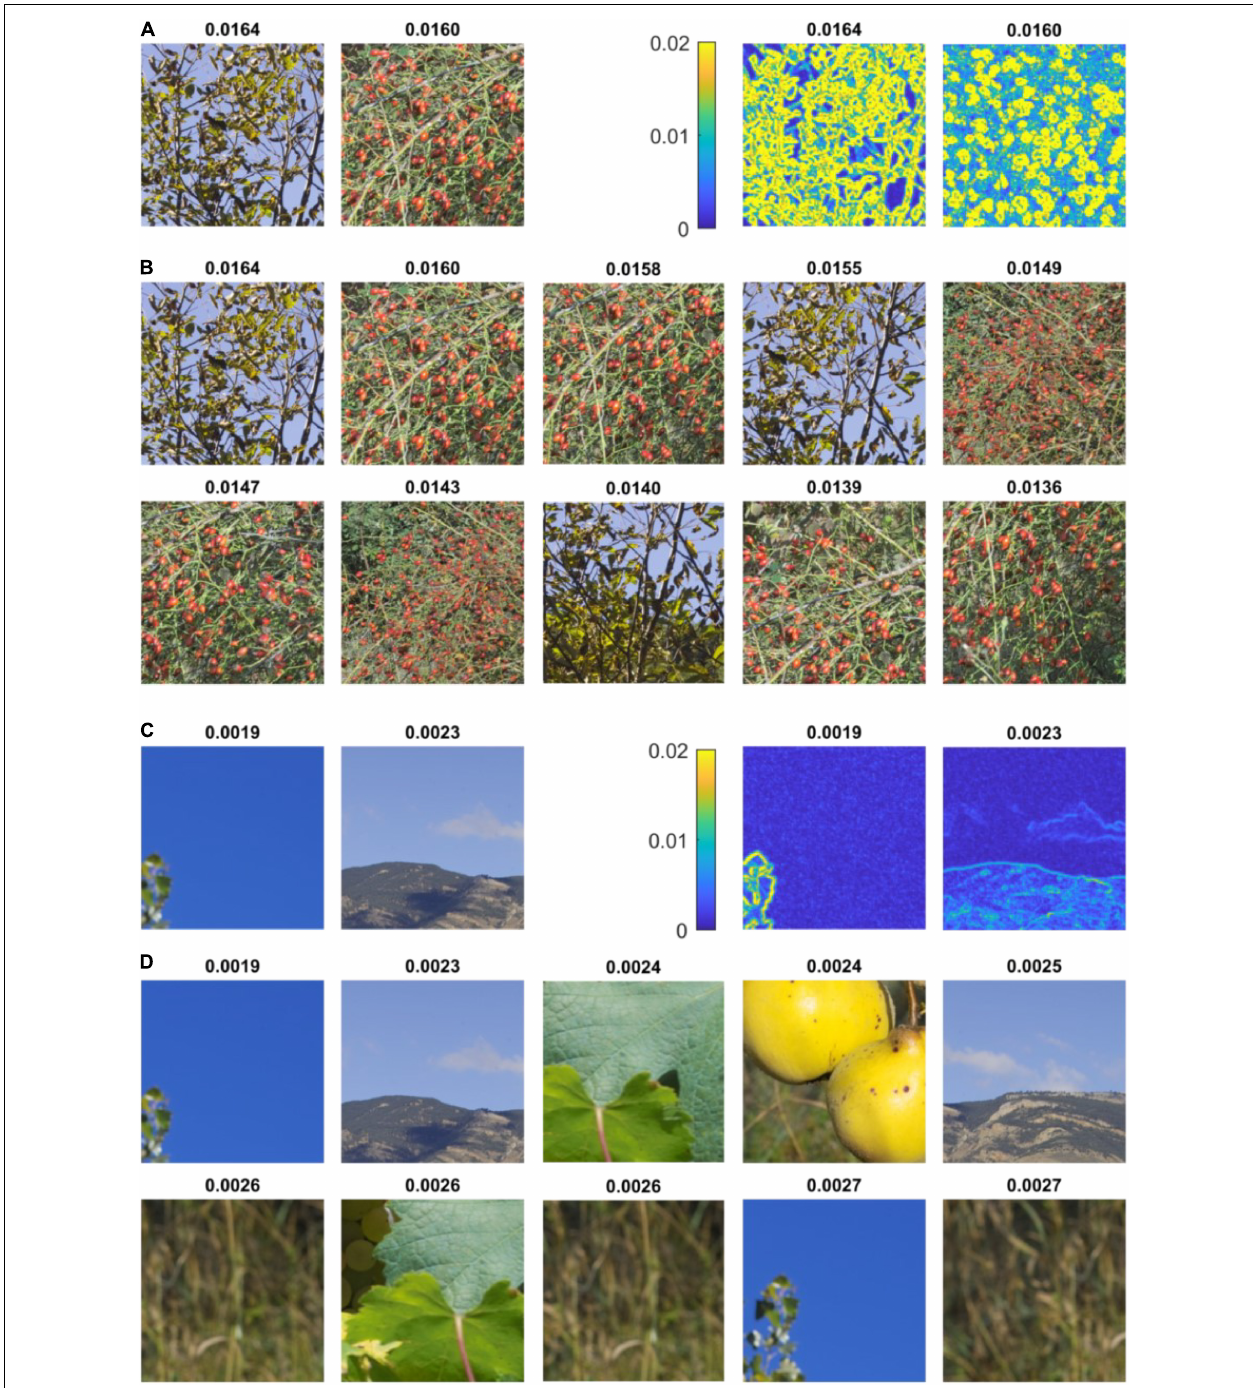
FIGURE 5 | Highest and lowest values of average chromaticity difference in natural scenes. (A) (left) First and second random patches with highest average chromaticity difference in set “Naturalistic 3” of the Barcelona calibrated database (Vazquez-Corral et al., 2009) and (right) respective heat maps of local chromaticity difference. The Average chromaticity difference in shown at the top of each inset. The first patch represents tree leaves (a species of genus ash, Fraxinus ) seen against a blue sky. The second patch shows ripe fruits of dog rose ( Rosa canina ) against green foliage. The heat maps show that chromaticity difference is high at the outline of leaves and fruits. (B) Ten first patches with highest average chromaticity difference in the same set, showing leaves against the sky and ripe fruits. (C) (left) Last two random patches of lowest average chromaticity difference in set “Naturalistic 3” of the Barcelona calibrated database and (right) respective heat maps of local chromaticity difference. The first patch shows a uniform blue sky and the second patch a mountain landscape. (D) Ten last patches with lowest average chromaticity difference in the same set of natural scenes. The patches show a uniform sky, mountain landscapes, close-up of leaves of vineyard and dried wild grasses. See Supplementary Figures 5–16 for a more comprehensive view of the extremes values of average chromaticity differences found in natural scenes.